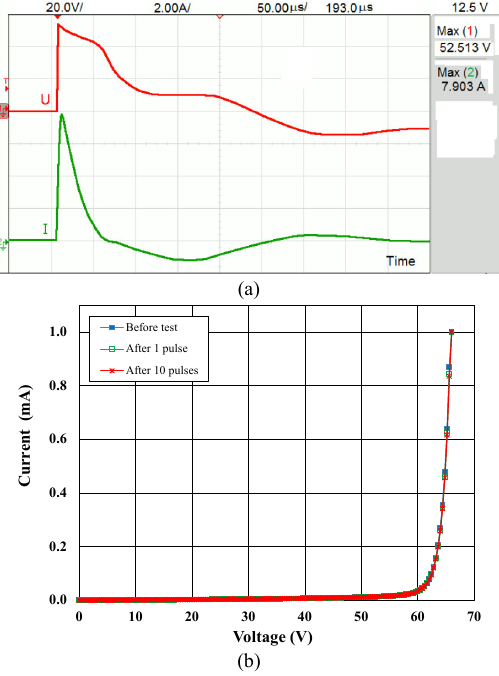
Fig. 10 (a) Impulse shape used for the surge current test (8/20 μs), (b) I – U characteristics of a multilayer varistor sintered at 1100 ℃ before and after the surge